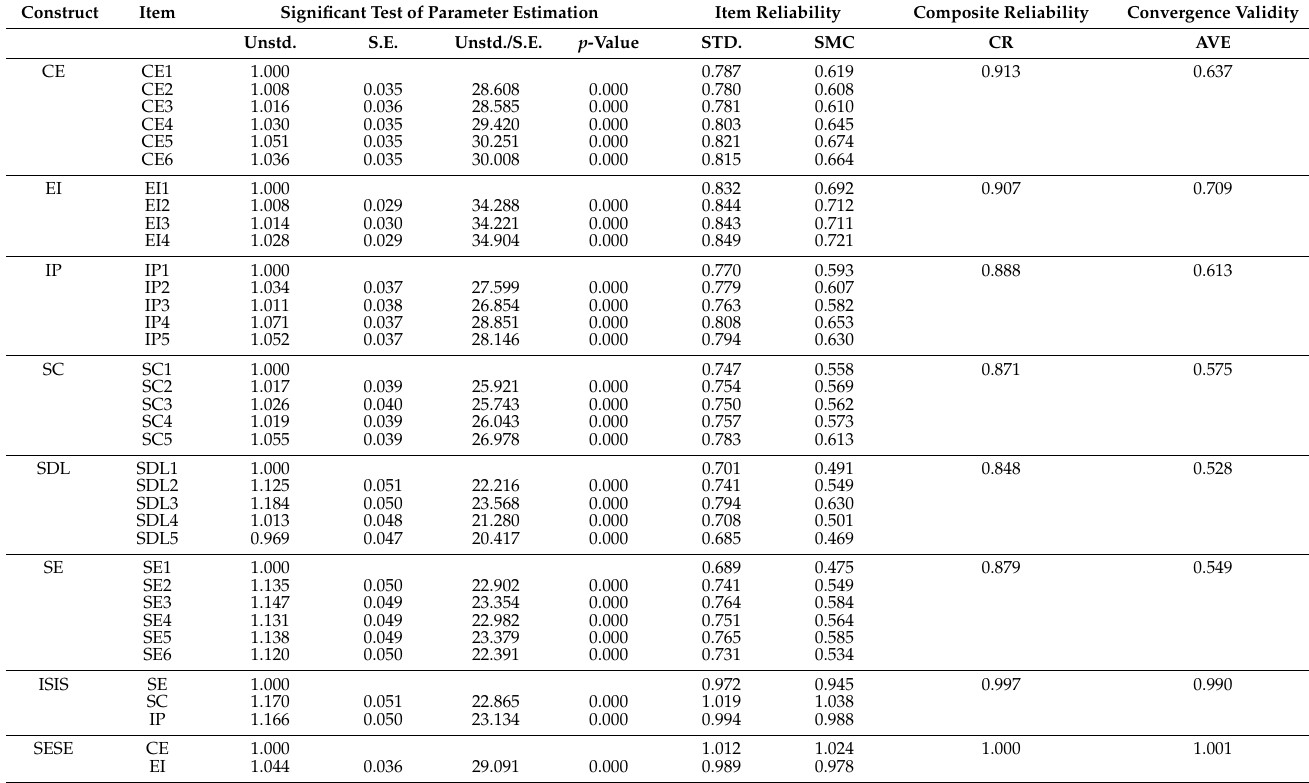
Table 3. Reliability and convergence validity